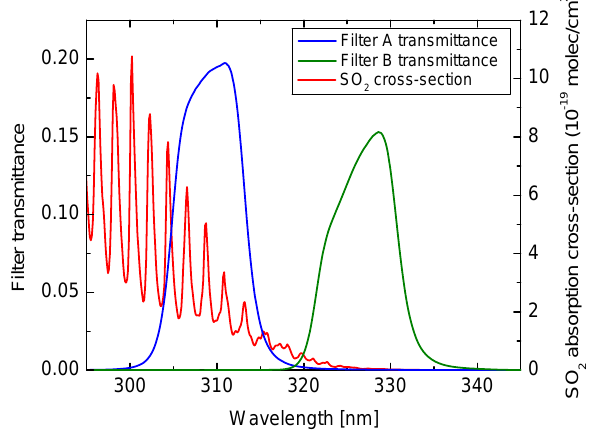
Fig. 9. Measured transmittance of the two band-pass filters used for Figure 9. Measured transmittance of the two band-pass filters used for construction of the SO 2 7 construction of the SO 2 camera prototype. Also shown (red) is the camera prototype. Also shown (red) is the absorption cross-section of SO 2 (Bogumil et al., 8 absorption cross-section of SO 2 (Bogumil et al., 2003). 2003). 9